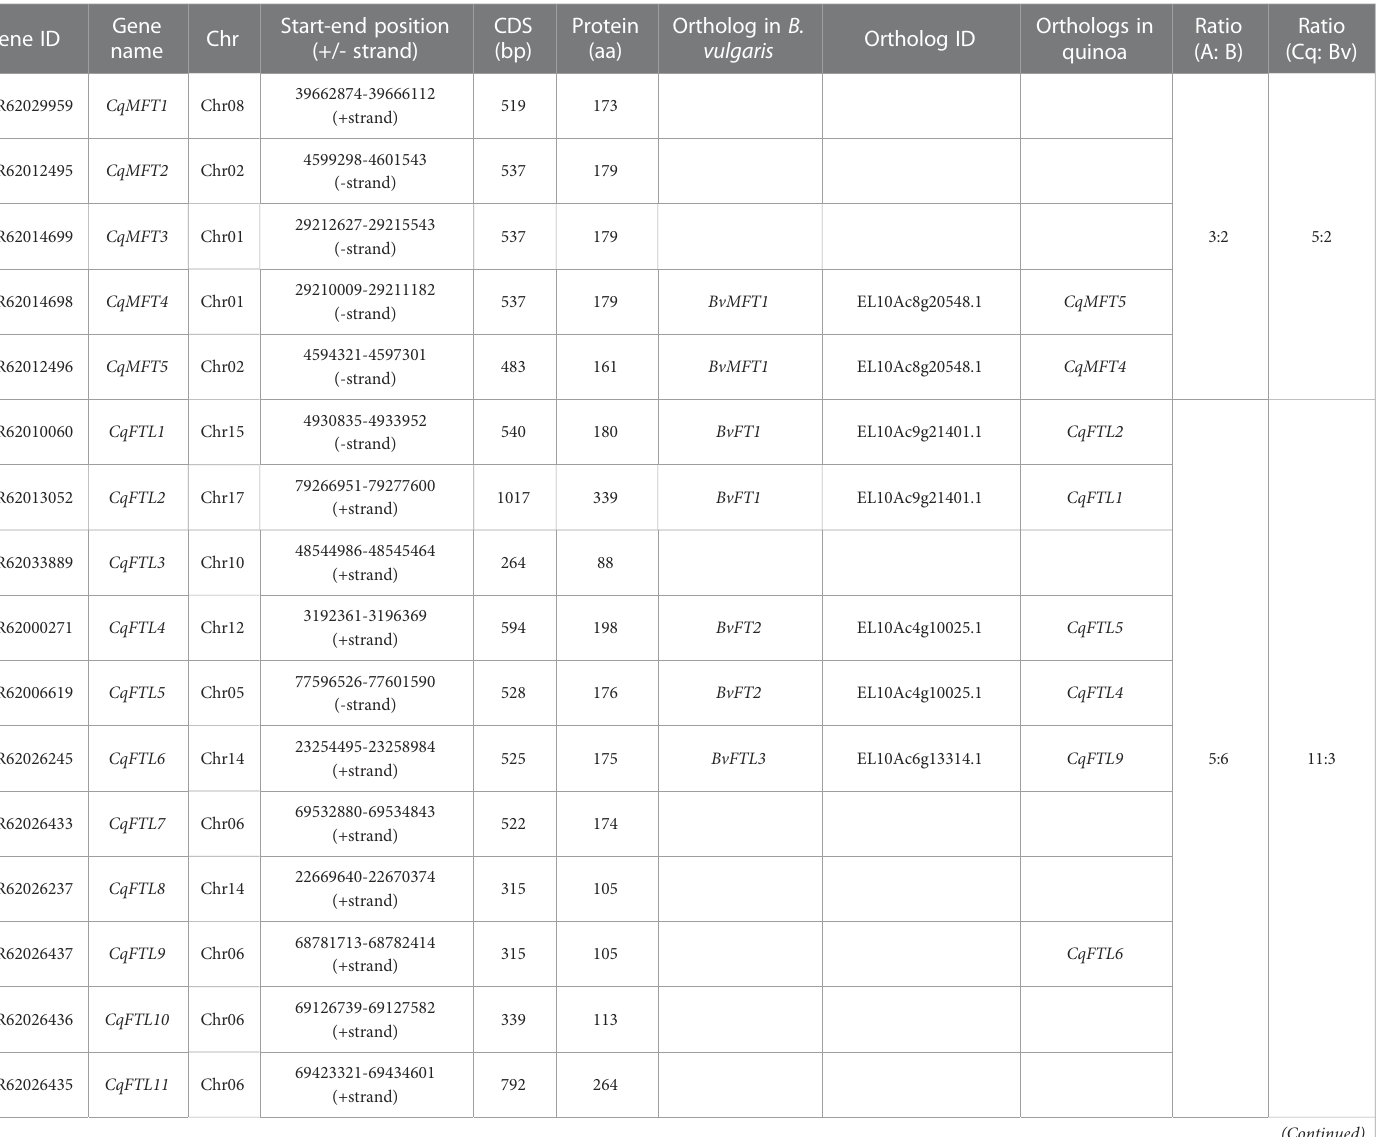
TABLE 1 Summary of PEBP gene family in C. quinoa and B. vulgaris